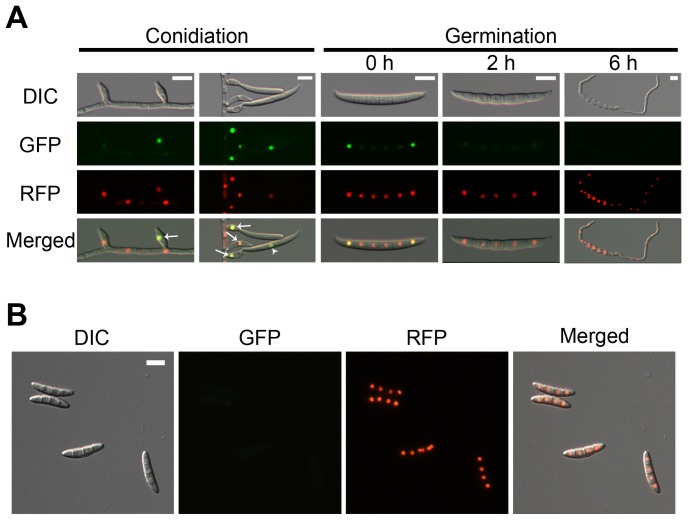
Cellular localization of AbaA.AbaA was fused with green fluorescent protein (GFP), and histone H1 was fused with red fluorescent protein (RFP). (A) The GFP signals were highly fluorescent in the phialides (indicated with arrows) and maturing conidia (indicated with arrow heads). The GFP signals became blurred after germination. (B) The GFP signals were undetectable in mature ascospores. Scale bar = 10 µm.